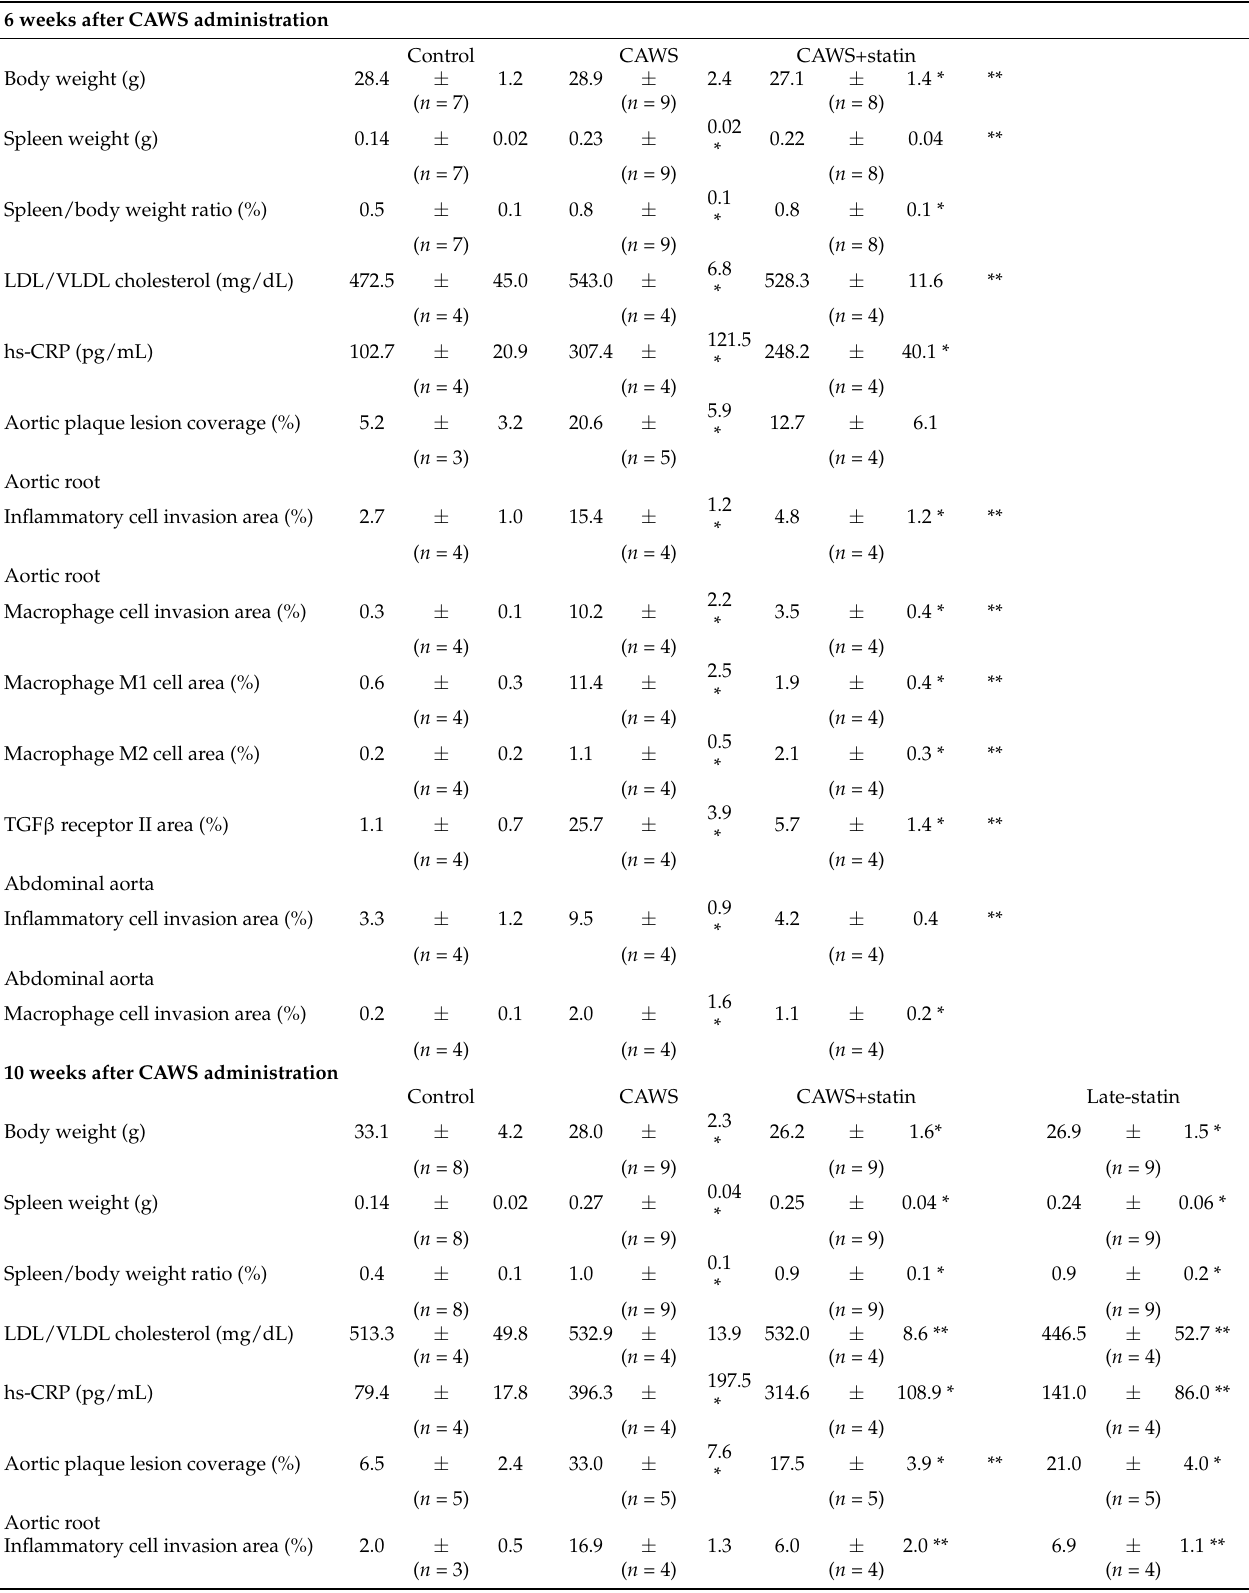
Table 1. Summary of the data at 6 and 10 weeks after CAWS